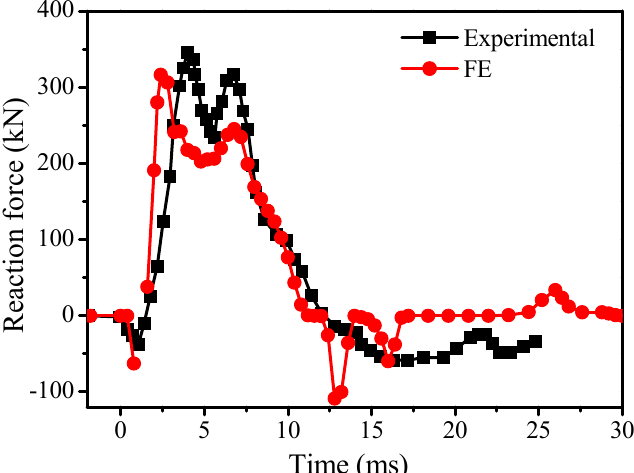
Figure 5. Comparison of reaction force time histories obtained from the FE simulation and experimental test.